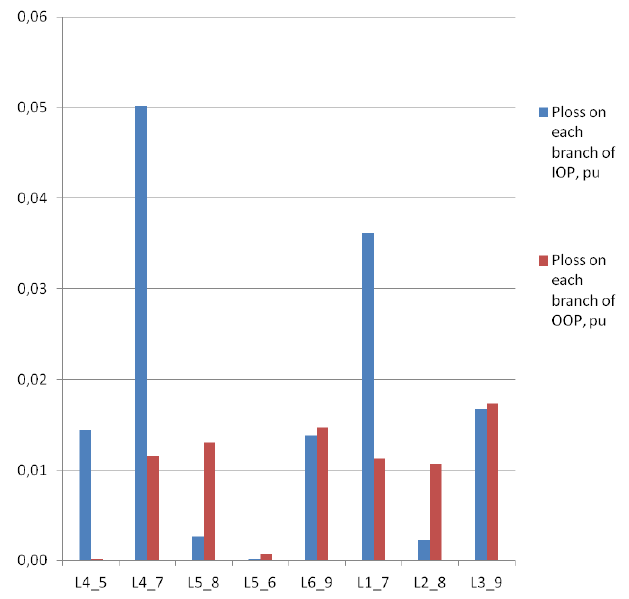
Figure 8. Power losses in each branch before (IOP) and after (OOP) the optimization.